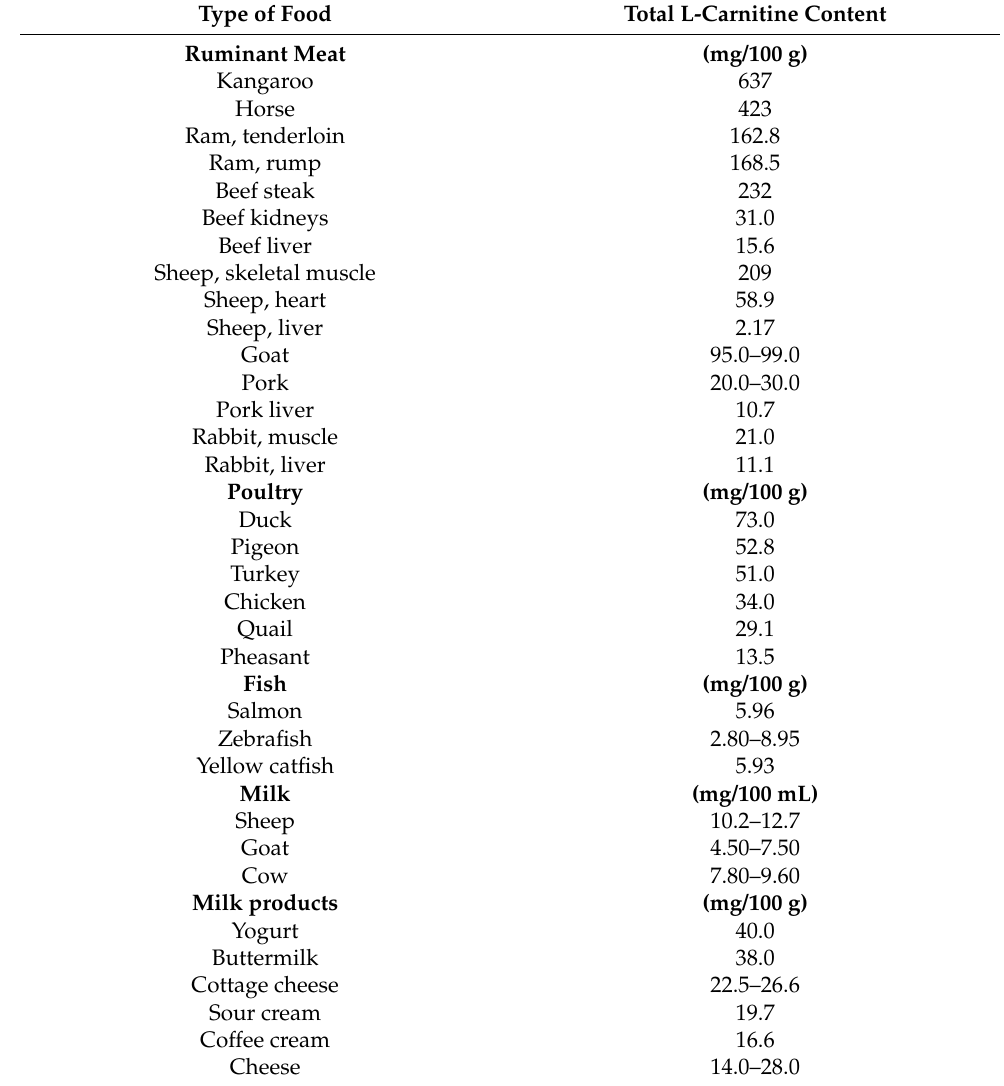
Table 1. The amount of L-carnitine in product